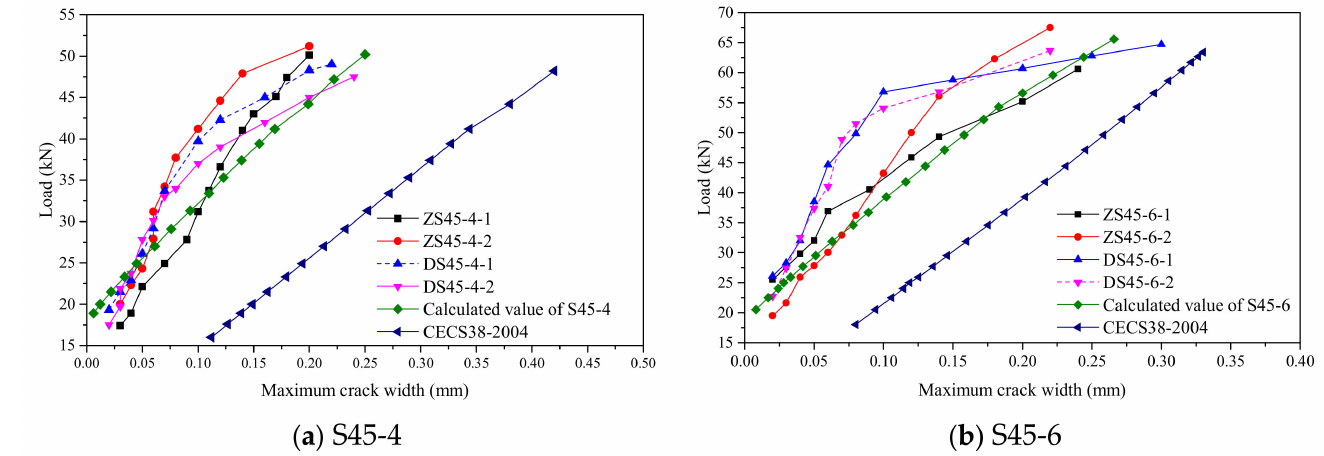
Figure 16. Load–Maximum-Crack-Width